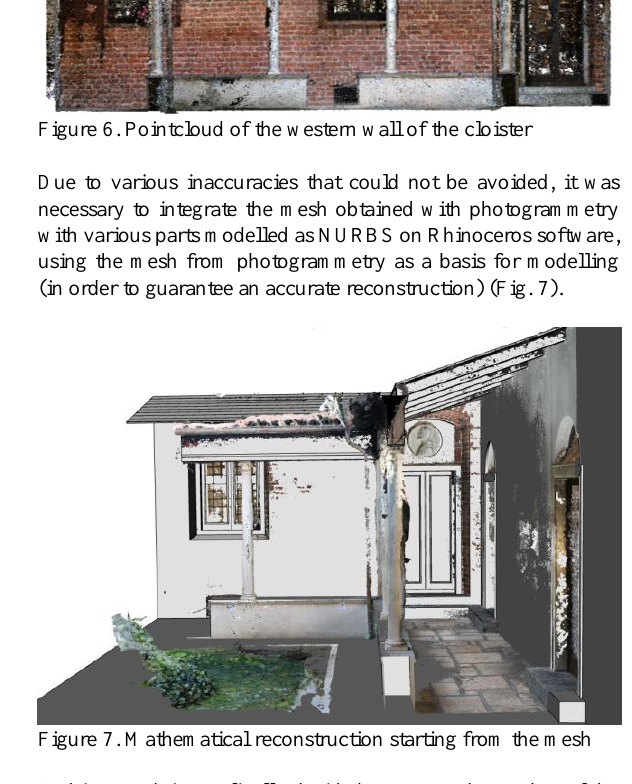
roof were modelled on Rhino. Instead, the capitals, the